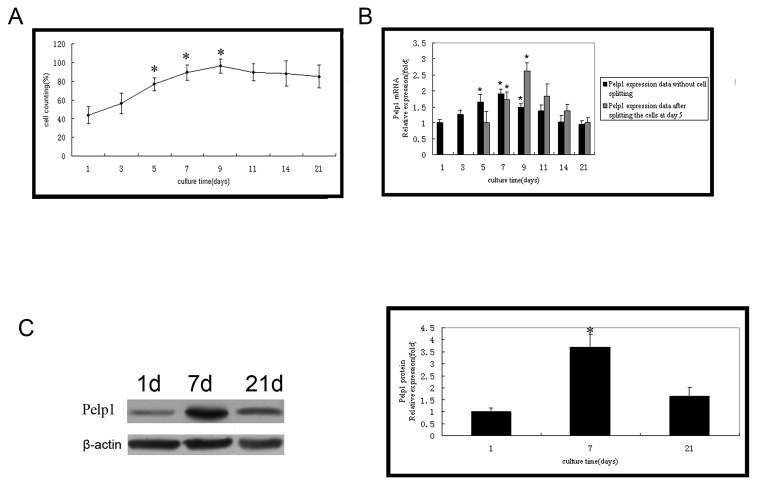
mRNA and protein expressions of Pelp1 in time in undifferentiated rBMSCs during a 21-day period.(A) Growth curve of undifferentiated rBMSCs. (B) Temporal changes in Pelp1mRNA expression were determined qRT-PCR. β-actin was used as an internal control. Pelp1 mRNA expression without splitting the cells was assessed at days 1, 3, 5, 7, 9, 11, 14 and 21 (left panel). *P<0.05 vs. baseline value (day 1). In another experiment, rBMSCs were split at day 5 to prevent them from reaching confluence at day 7, and Pelp1 mRNA expression was assessed at days 7, 9, 11 and 14 (right panel). #
P<0.05 vs. value at day 5. (C) Temporal changes in Pelp1 protein expression were determined by western blotting. β-actin was used as an internal control. Data represent the mean ± SD of three independent experiments. *P<0.05 vs. baseline value (day 1).